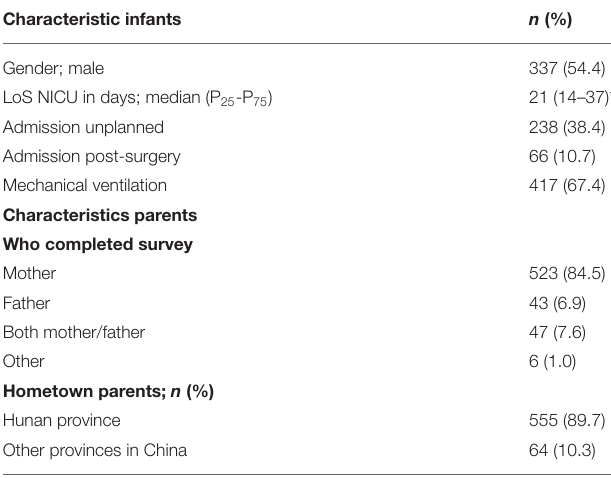
TABLE 1 | Infant characteristics and parent characteristics ( n =